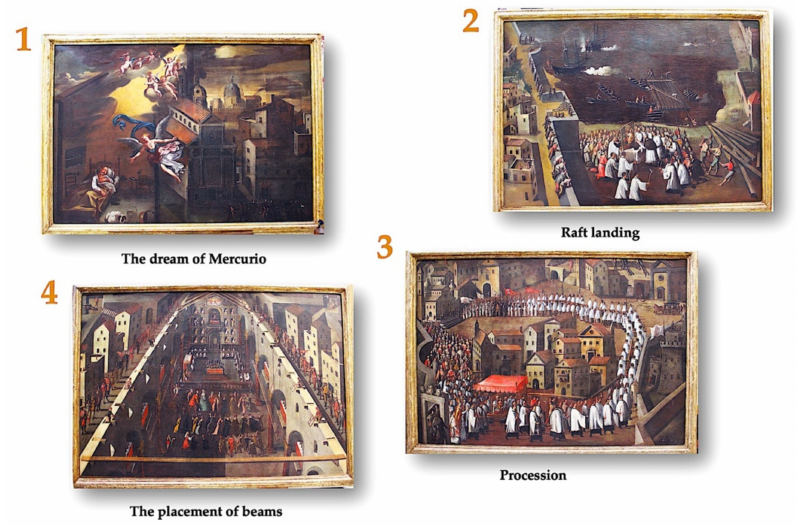
Figure 1. The four canvases of the painting cycle made by the artist Nicol ò Maria Signorile.